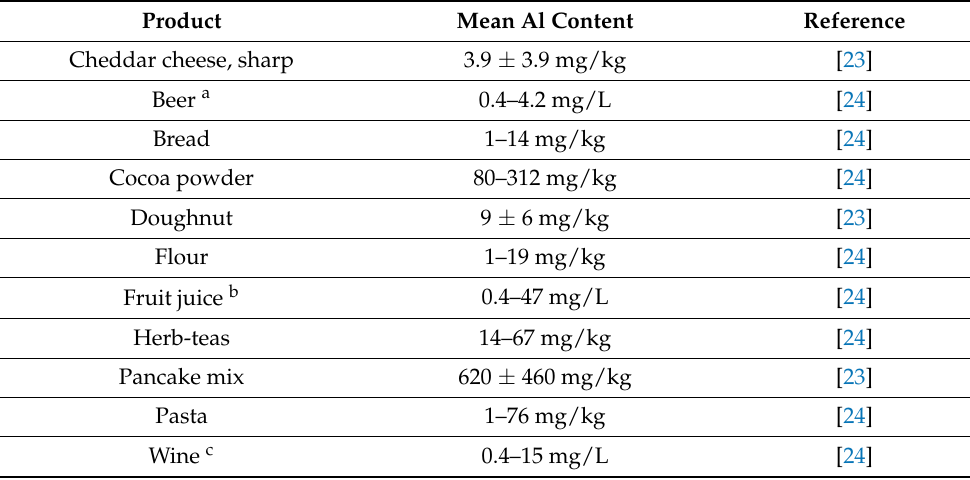
Table 2. Examples of food and beverage content of aluminium.